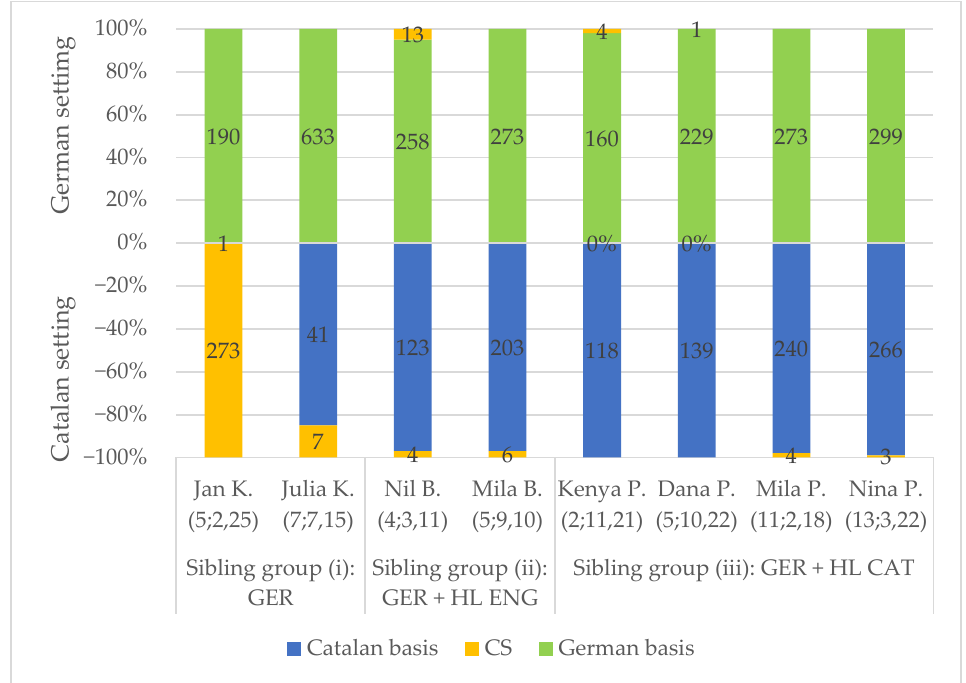
Figure 16. Siblings’ Catalan and German basis and CS.